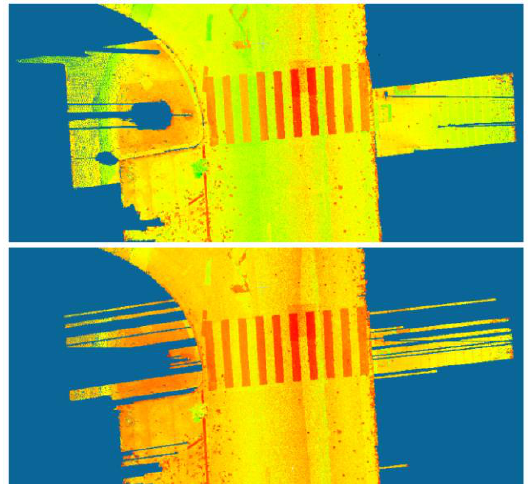
Figure 5. Comparison of HDB with four-neighbourhood region growing (top) and HD with two-neighbourhood region growing (down)